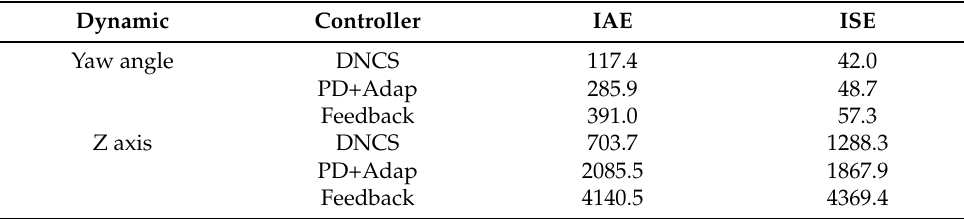
Table 3. Performance index comparison for yaw and depth trajectory tracking.